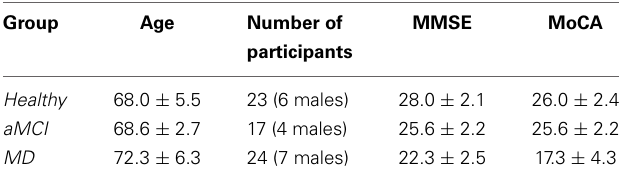
Table 1 | Mean age, sex and cognitive status for the participants of each group enrolled in the present